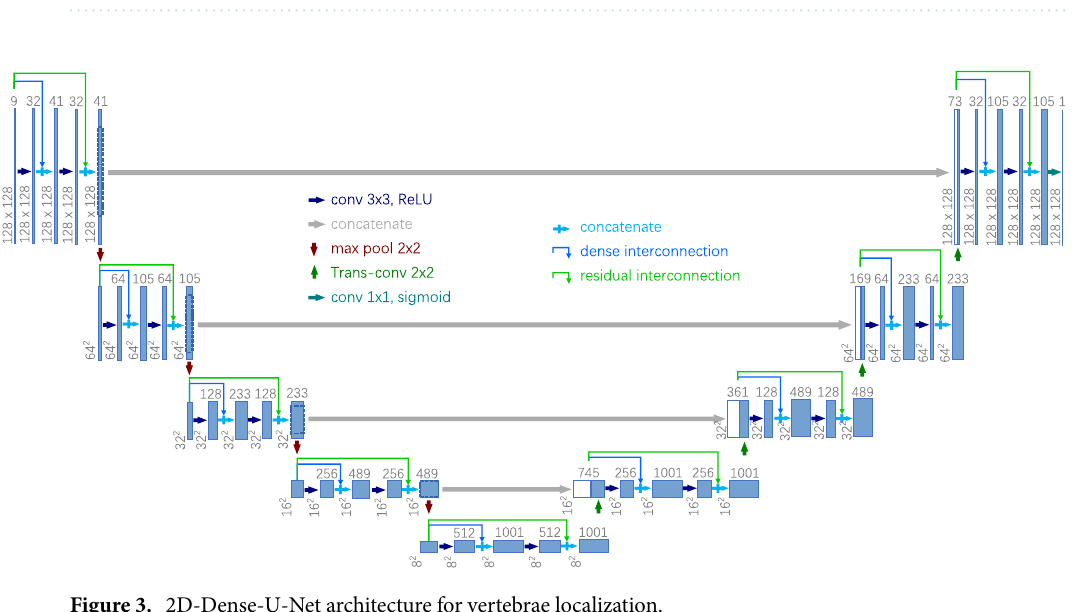
Figure 3. 2D-Dense-U-Net architecture for vertebrae